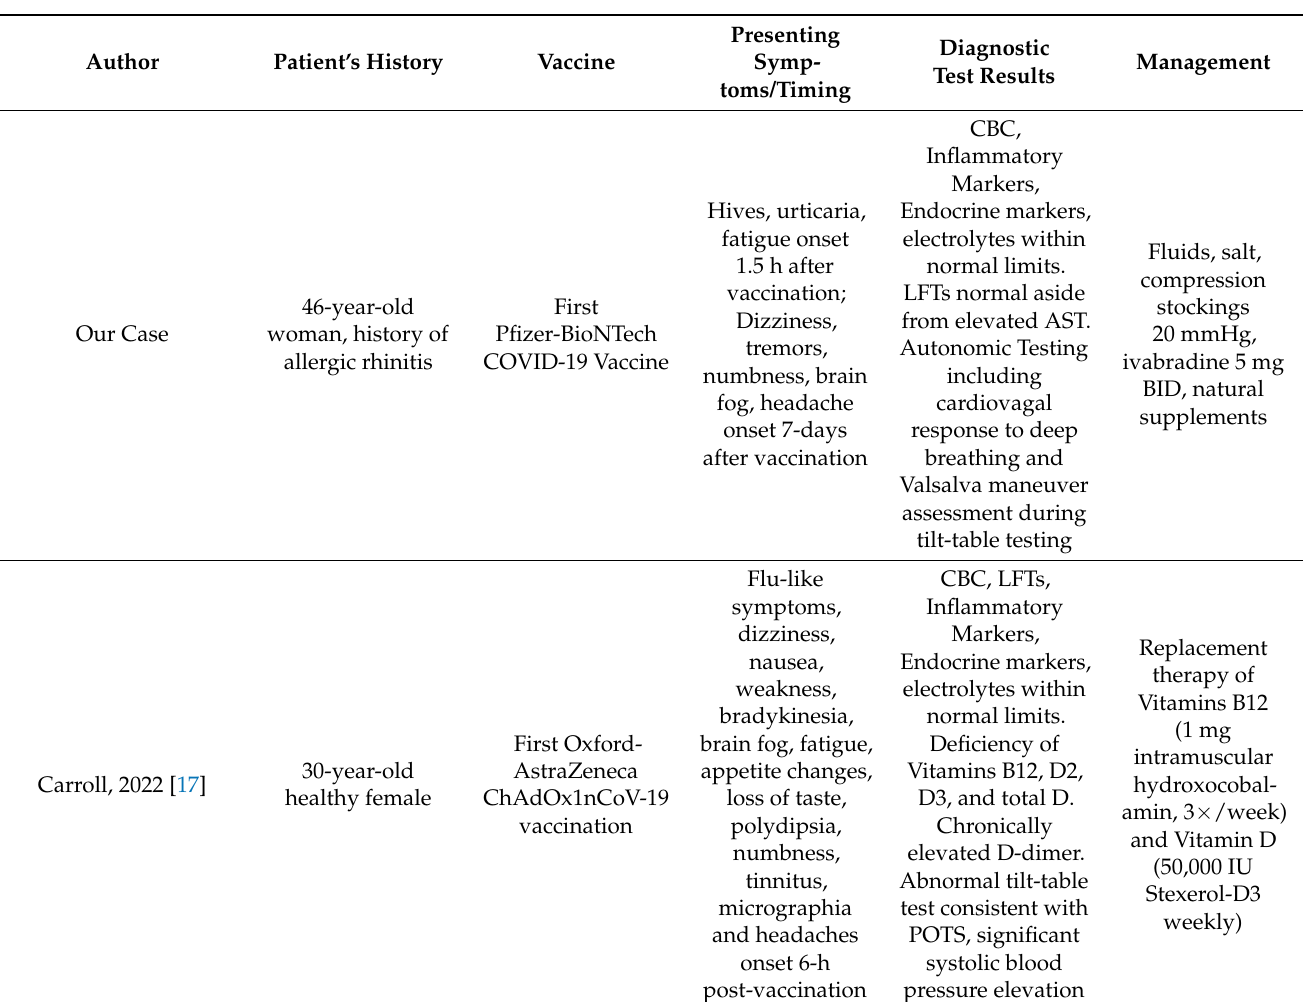
Table 2. Case reports and series of POTS after COVID-19